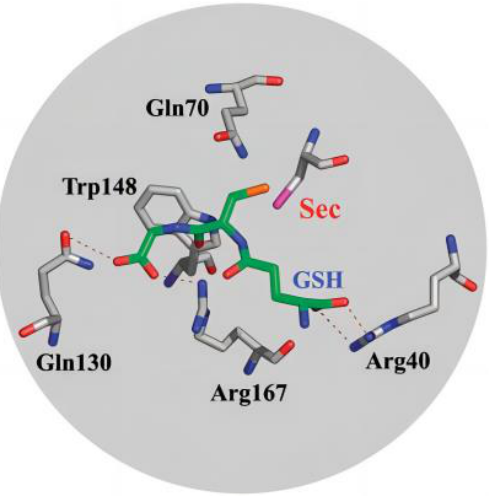
Figure 1. cGPx activity site map: structure for GSH and Arg40, Arg167, and Gln130. Reproduced with permission from X. Huang, et al. [10].